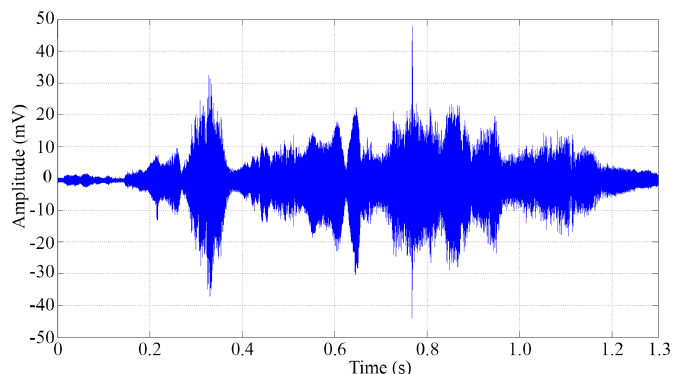
Figure 20. AE signal recorded on the bearing housing. Drying of lubricant.